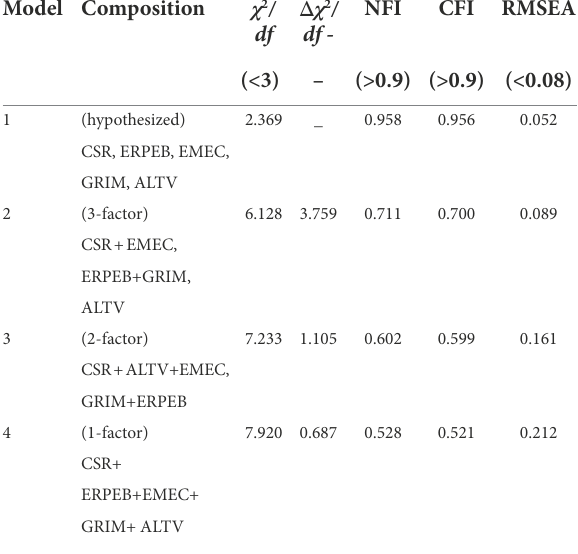
TABLE 5 Model fit comparison, alternate vs. hypothesized models. Model Composition